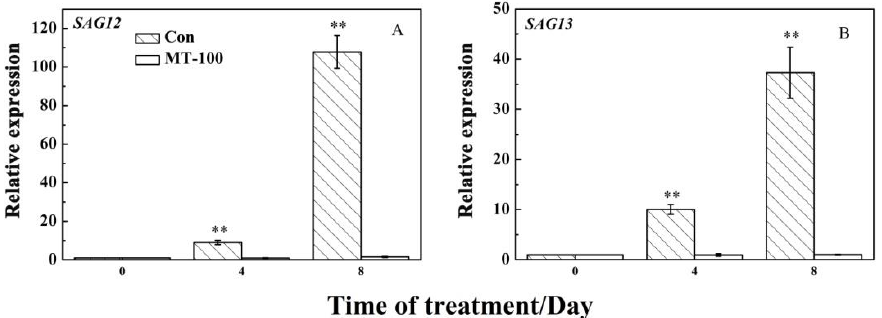
Figure 6. E ff ects of MT on senescence-associated genes (SAGs) expression in detached grapevine leaves during dark-induced senescence. ( A ) Expression level of SAG12. ( B ) Expression level of SAG13. ** and * indicate significant di ff erences at 0.01 and 0.05 levels,